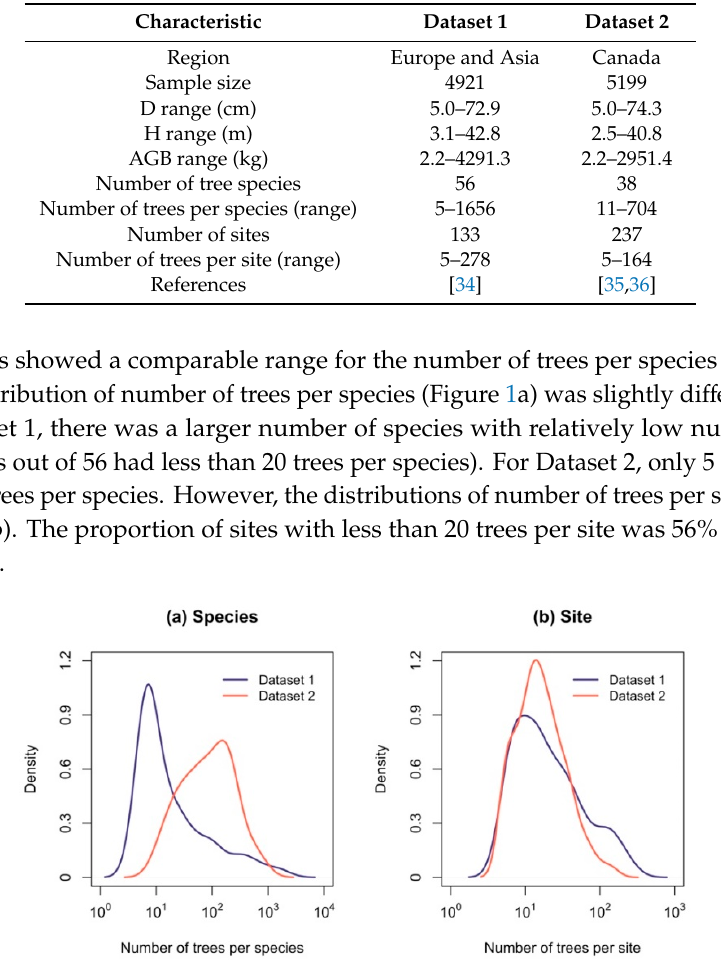
Figure 1. The number of trees per species ( a ), and the number of trees per site ( b ) presented in base 10 log scale.